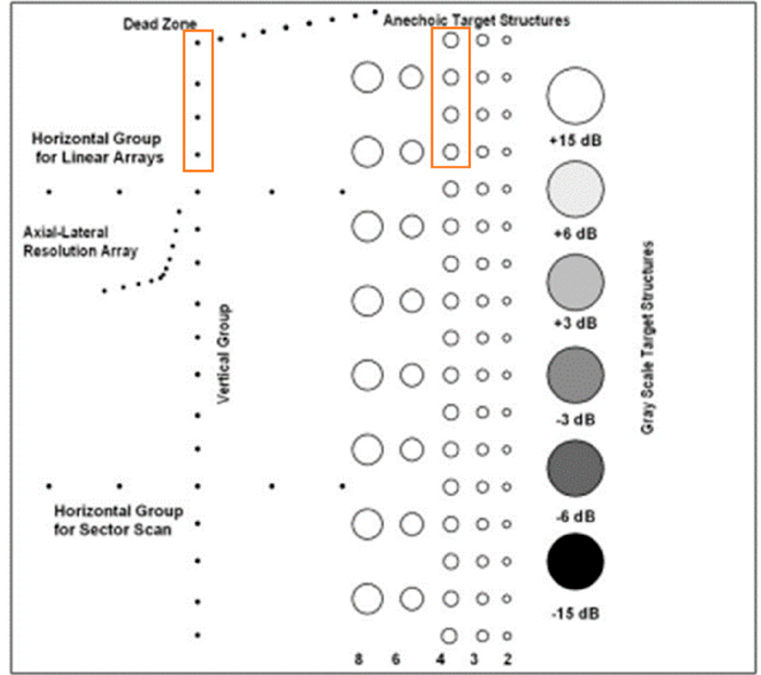
Figure A1. Cross-section of the multi-purpose phantom and the needles and lesions used for analysis indicated by the orange rectangular boxes. Table A1. Axial and lateral resolution, and contrast-to-noise ratio (CNR) by DaS (F-number of 0.875). Transducer